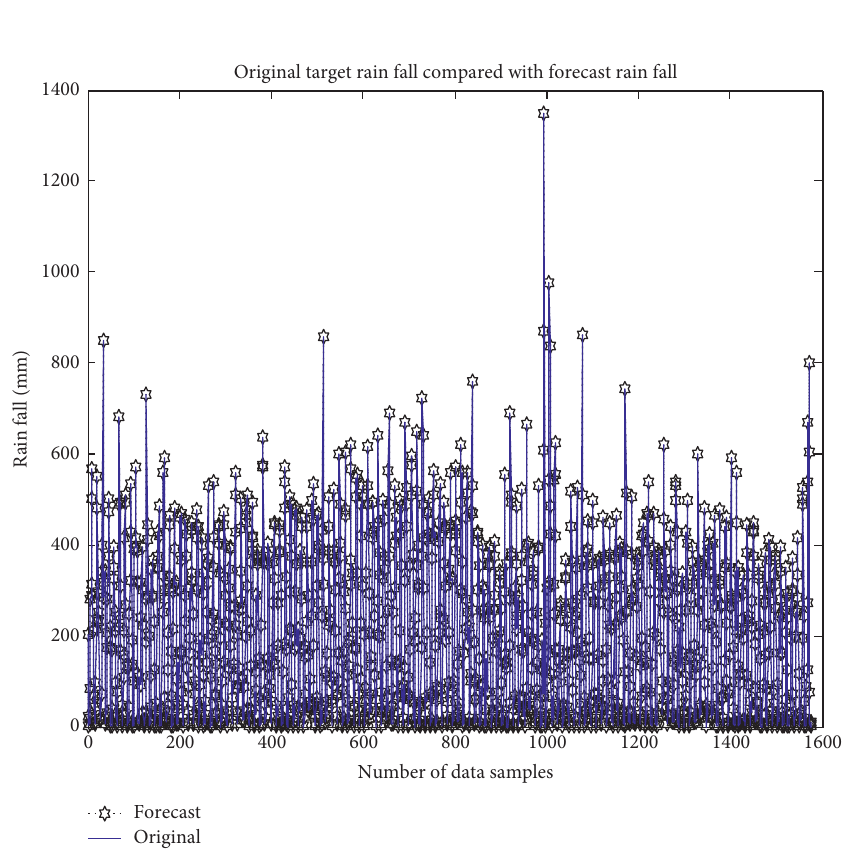
Figure 11: Original target rainfall compared with forecast Figure 14. Temperature vs. data samples is presented in Figure 15. Comparison between target and forecasted temperature is presented in Figure 16. Error vs. number of data is shown in Figure 17, the relationship between target and forecast temperature, respectively. Due to the space limitation, portions of the obtained results are shown in Figures 14–17.